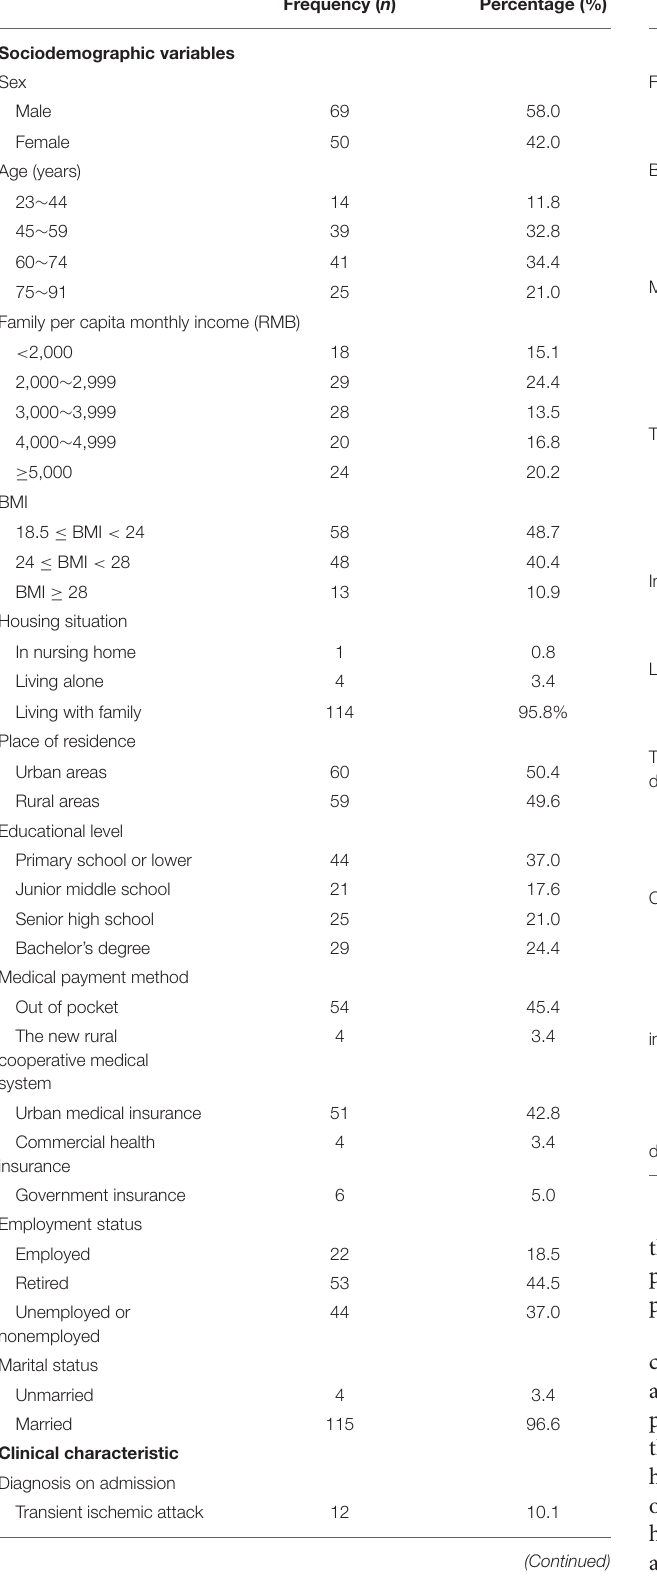
TABLE 1 | Sociodemographic and clinical data of the participants ( n =